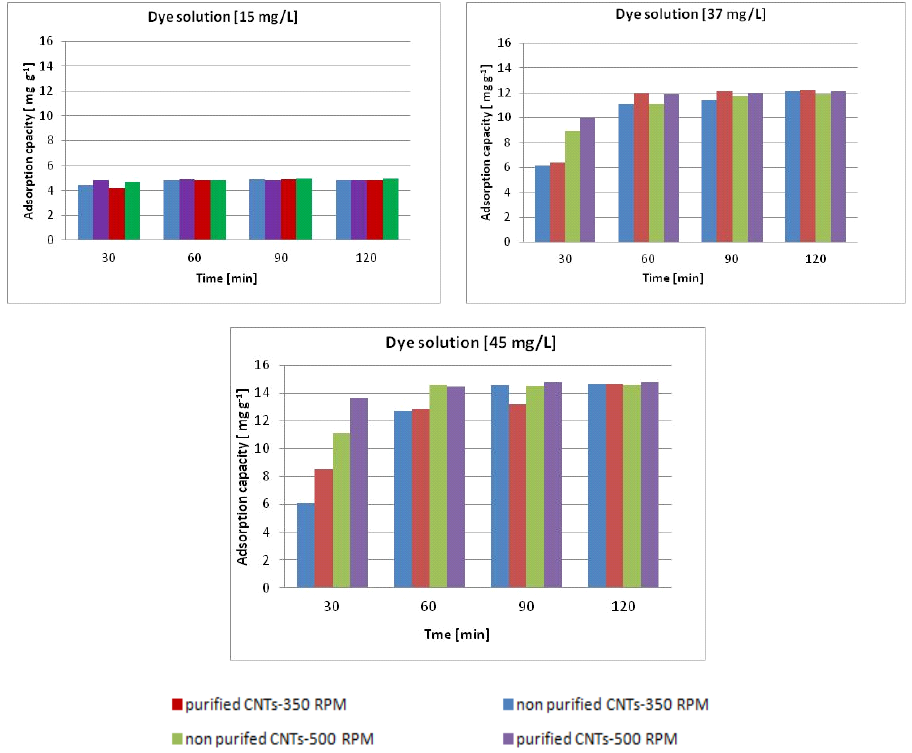
Figure 8. Adsorption capacity in solutions with different concentrations as a function of contact time.